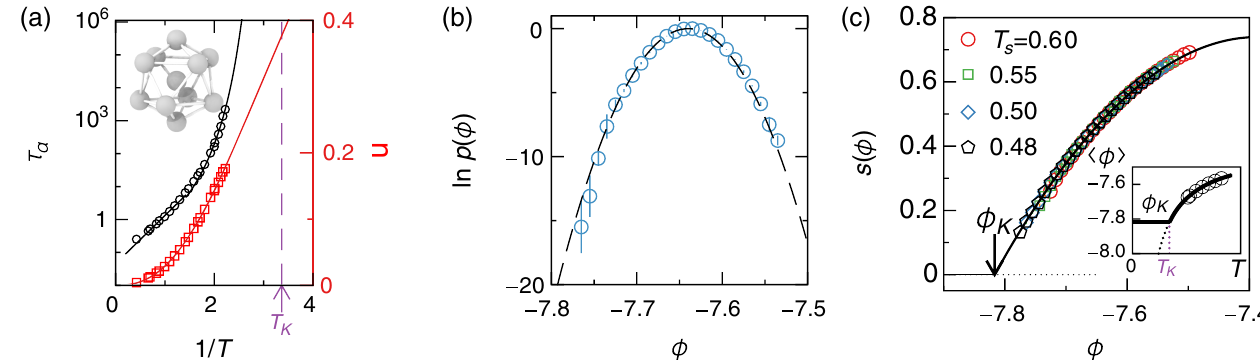
− 1 (solid line), K Þ 0 . 5 ). (c) Collapse of the s ¼ to K